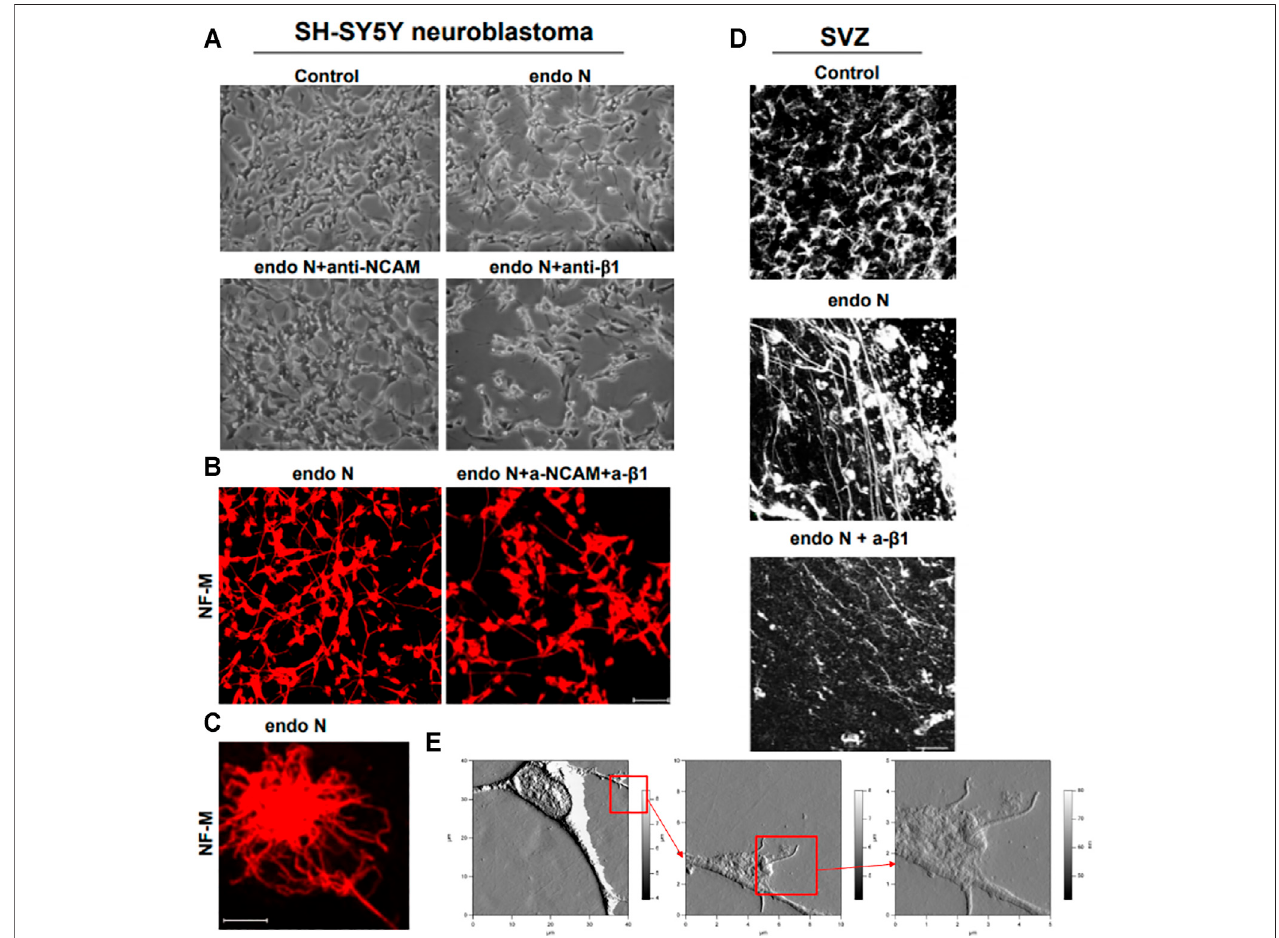
FIGURE 9 | Neuroblastoma cells of a SH-SY5Y cell-line treated with endo N, which speci fi cally cleaves polysialic acid (PSA) from NCAM. Neuritogenesis of these cells occurred (A) . Induction of neuro fi lament M (NF-M)-positive neuronal processes (B,C) is clearly inhibited by the use of an NCAM-blocking antibody (A) . β 1- Integrinblocking antibody signi fi cantly inhibited the endo N induced effect on neuritogenesis (A) . Inhibition of endo N-induced neuritogenesis by β 1-integrinblockage is notonlyappliedinneuroblastomacellsbutalsoinsubventricularzone(SVZ)progenitorcells.9DshowsthatneuriteoutgrowthinSVZexplantculturesisinducedby endo N. Addition of β 1-integrin blocking antibody reduces the effect of endo N. Beside polysialic acid (PSA) a sulfated oligosaccharide (the HNK1 epitope) plays an important role as marker on neuroblastoma cells. Therefore, AFM (Atomic Force Microscopy) presentations of a HNK-1 positive neuroblastoma cell are shown (E ) in different